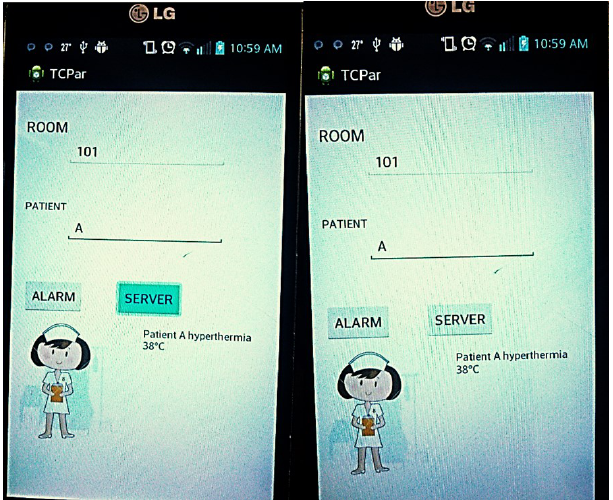
Figure 11. Patient hyperthermia condition alarm displayed on the mobile nurse